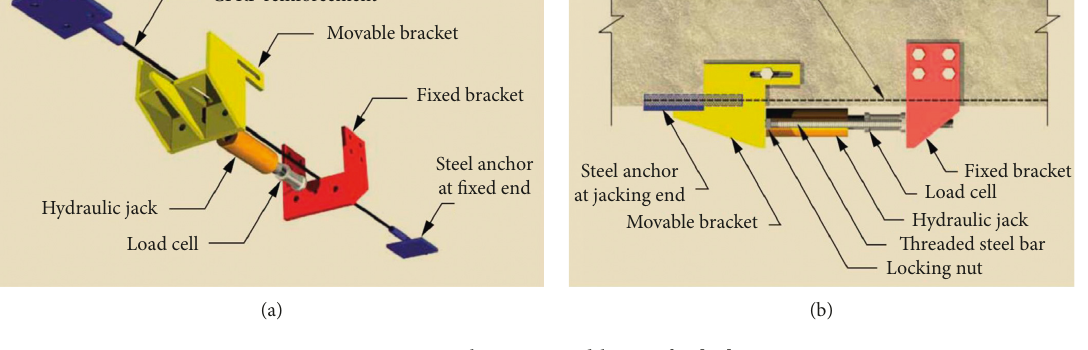
Figure 8: Anchor proposed by Gaafar [13].